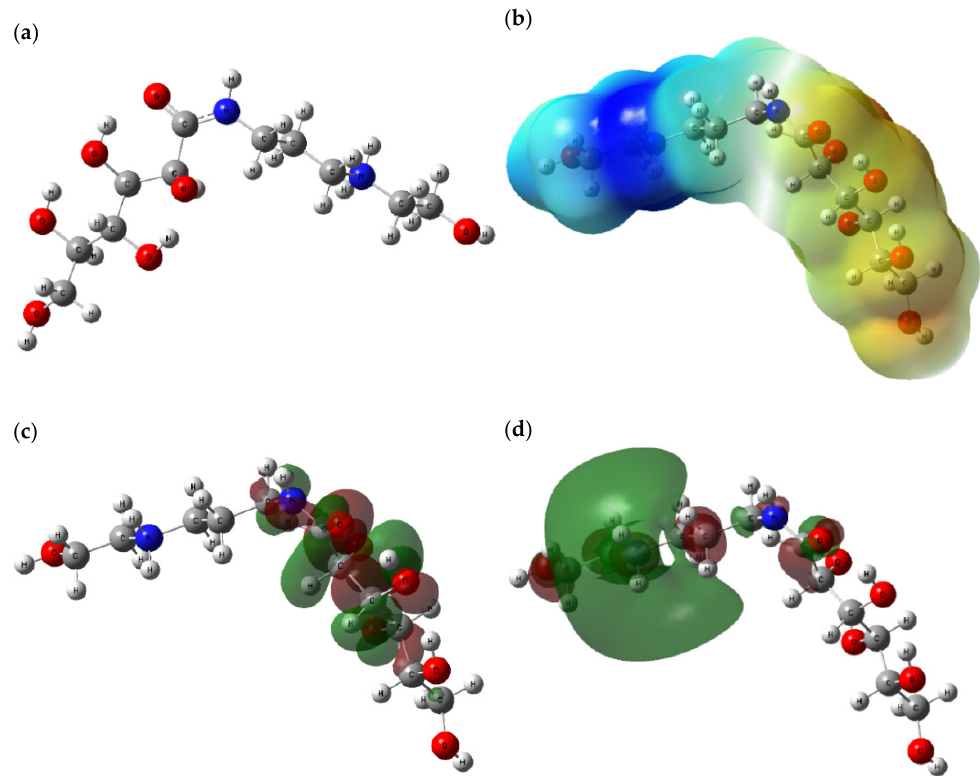
Figure 12. ( a ) Optimized structure, ( b ) ESP, ( c ) HOMO, and ( d ) LUMO of Q-22 inhibitor at the B3LYP/6-311+g (d,p) level of theory.